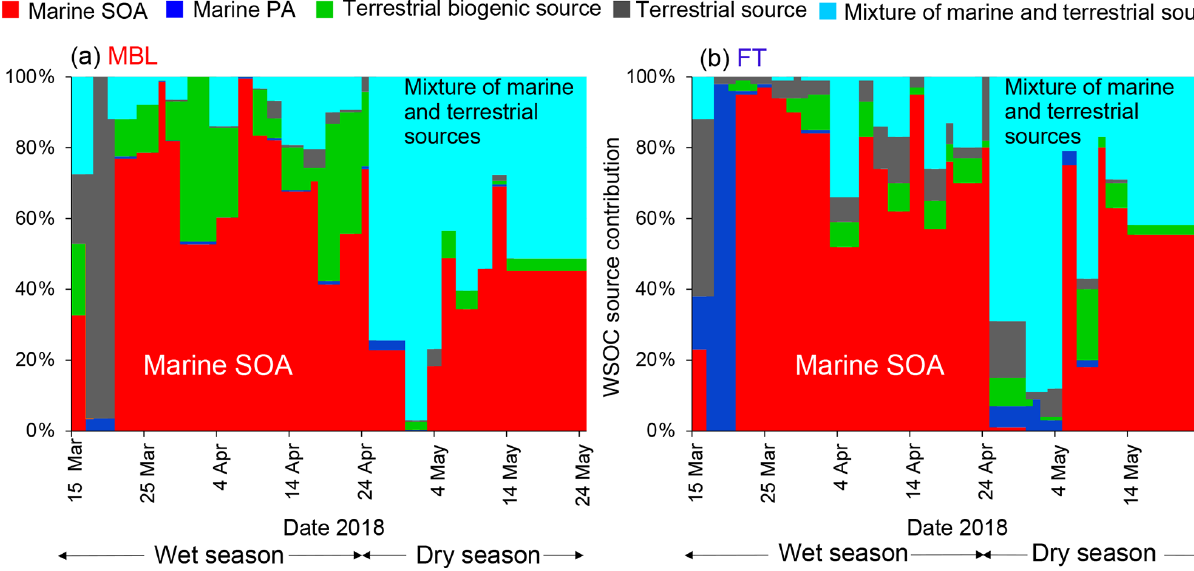
Figure 8. Time series of contribution of each PMF-derived factor to the WSOC mass concentration under the (a) MBL and (b) FT conditions.